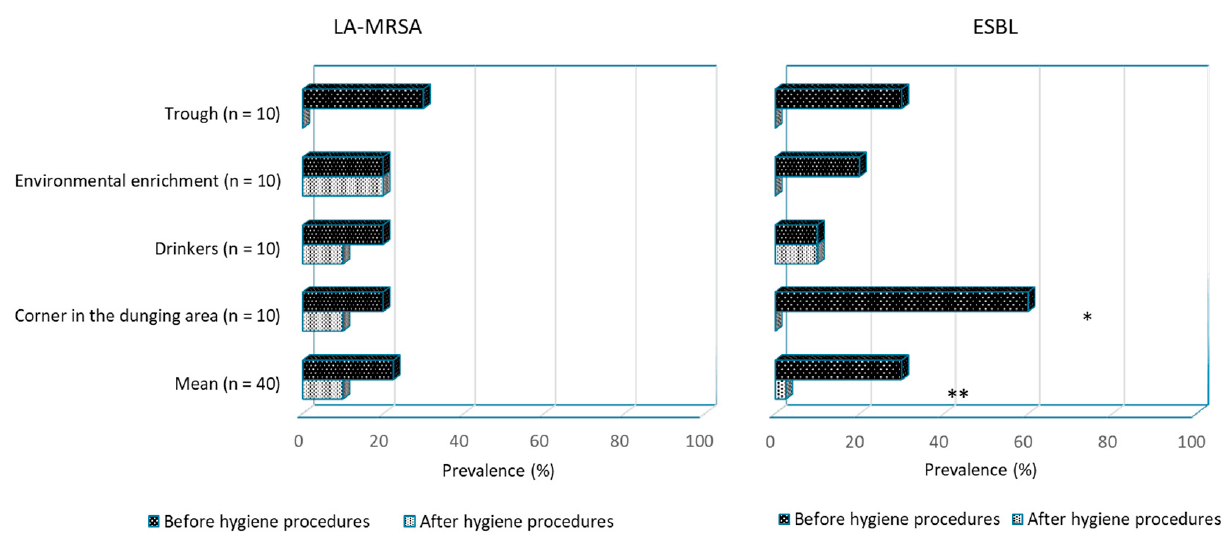
Figure 4. Prevalence at the beginning of the study (first visit) of livestock-associated methicillin- resistant Staphylococcus aureus (LA-MRSA) and extended-spectrum β -lactamase (ESBL) producing E. coli in environmental samples for each sampling site in 10 pig farms. * p -value < 0.05; ** p -value < 0.01.